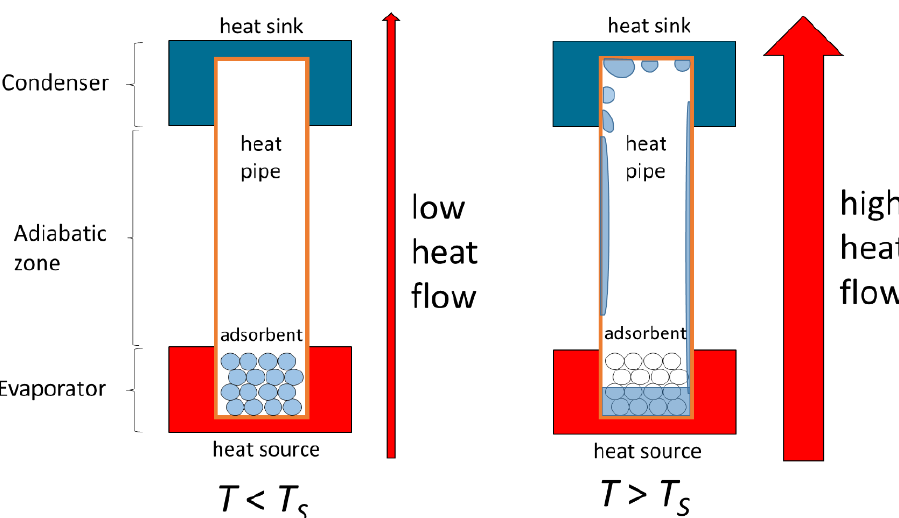
Figure 1. Basic concept of thermal heat switch. Below the activation temperature or switching temperature T S , the working fluid is in an adsorbed state and the heat pipe exhibits a high thermal resistance. Above T S , the working fluid is released by desorption. Latent heat transport is enabled, significantly lowering the thermal resistance of the heat pipe.